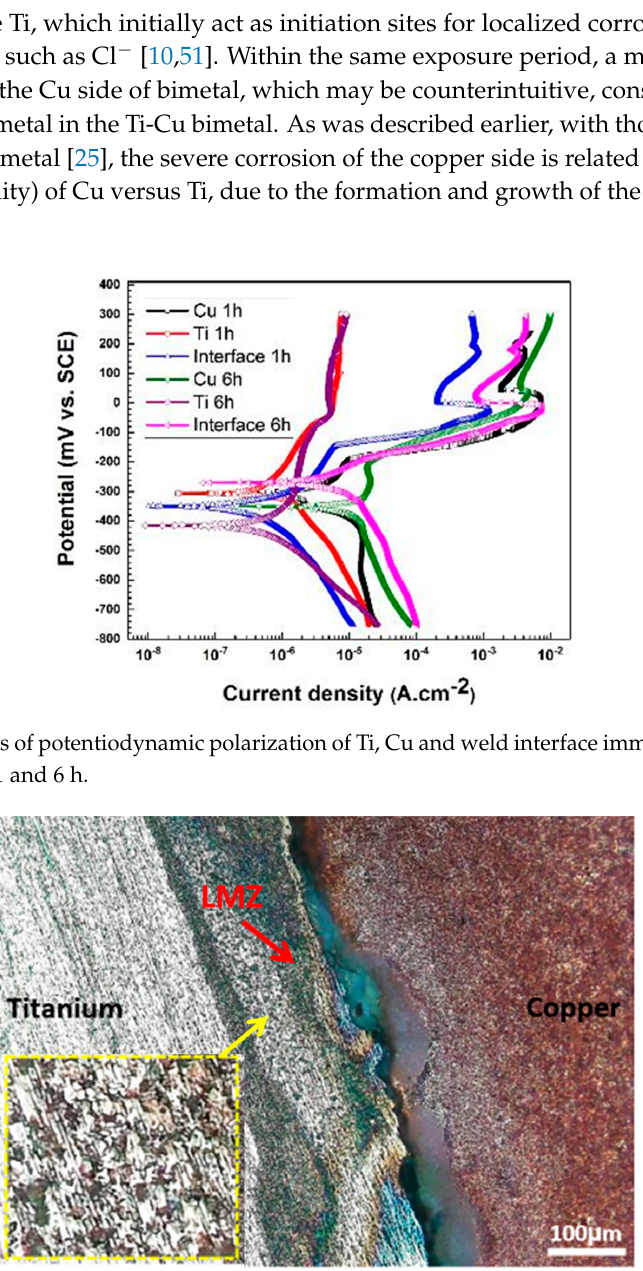
Figure 12. ( a ) Optical micrograph of the galvanic corrosion in the welded zone after PDP test in 3.5 wt. % NaCl solution. The inset shows a greater magnification of the localized corrosion attacks on the Ti side. The red arrow depicts the local melted zone at the joint interface.